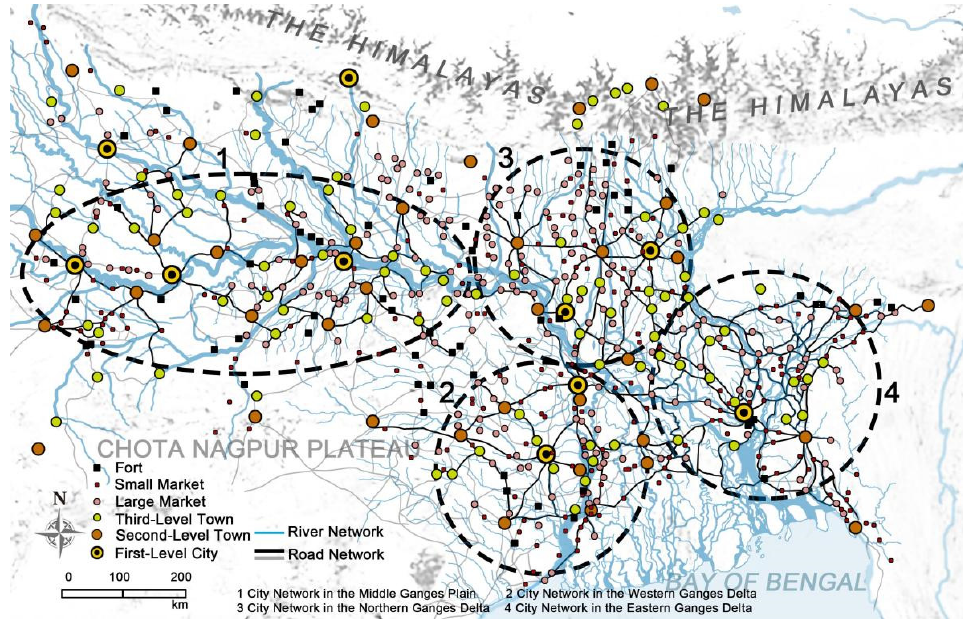
Figure 12. Four subregional city networks in the middle and lower Ganges Valley in the mid-18th century. Source: the authors; Base Map: Google satellite map; Reference: [65].